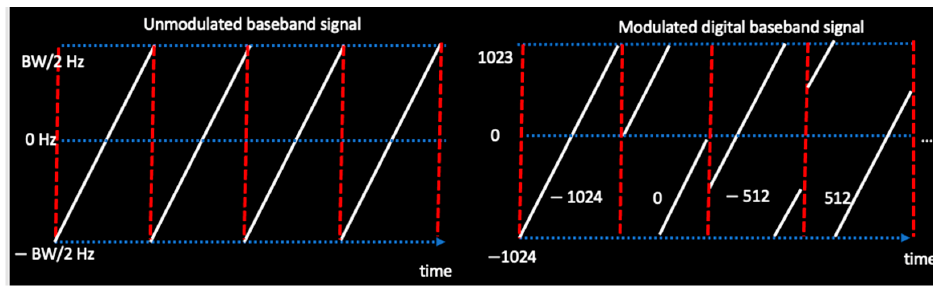
Figure 2. The LoRa modulation example in frequency versus time domain with SF ‐ 11 .